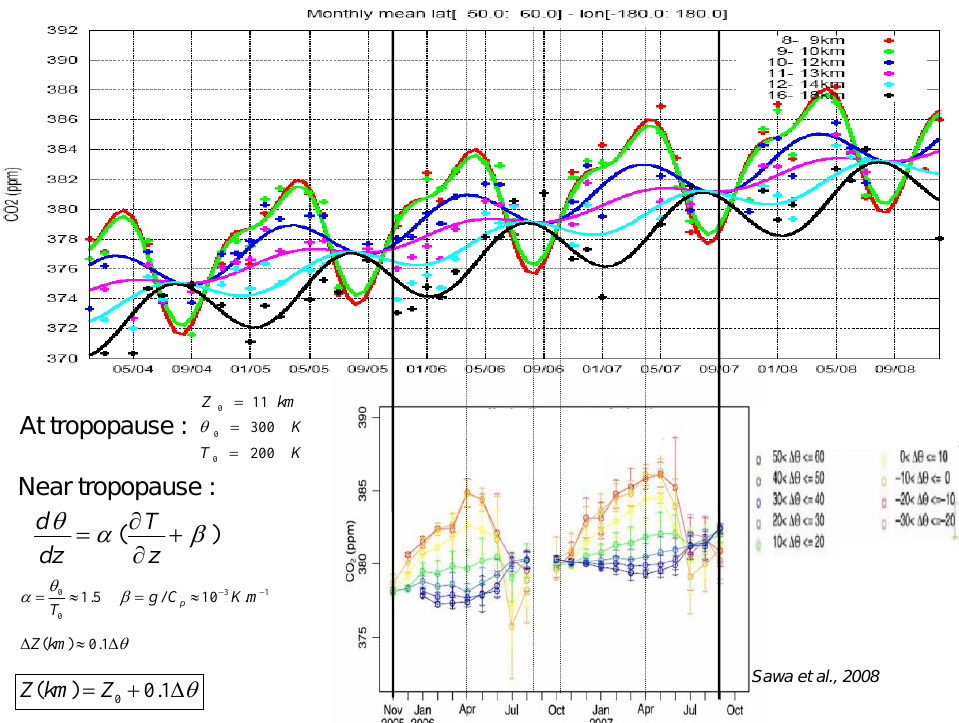
Fig. 6. Top: Temporal evolution of CO 2 concentration retrieved from ACE-FTS measurements for six atmospheric layers from 8 to 18 km (see color legend). Crosses show the retrievals (monthly mean) and the curves result from the harmonic polynomial fit (two harmonics for the first two layers, one for the remaining four) to the retrievals at different altitudes. Bottom: Temporal evolution of CO 2 concentration from CONTRAIL measurements (Sawa et al., 2008) above Eurasia from November 2005 to September 2007. Each curve represents CO 2 time series observed at 10K potential temperature bins from the local tropopause. An approximate relationship between θ (potential temperature) and altitude is given at the bottom left of the figure. Blue curves correspond to the lower stratosphere and orange curves to the higher